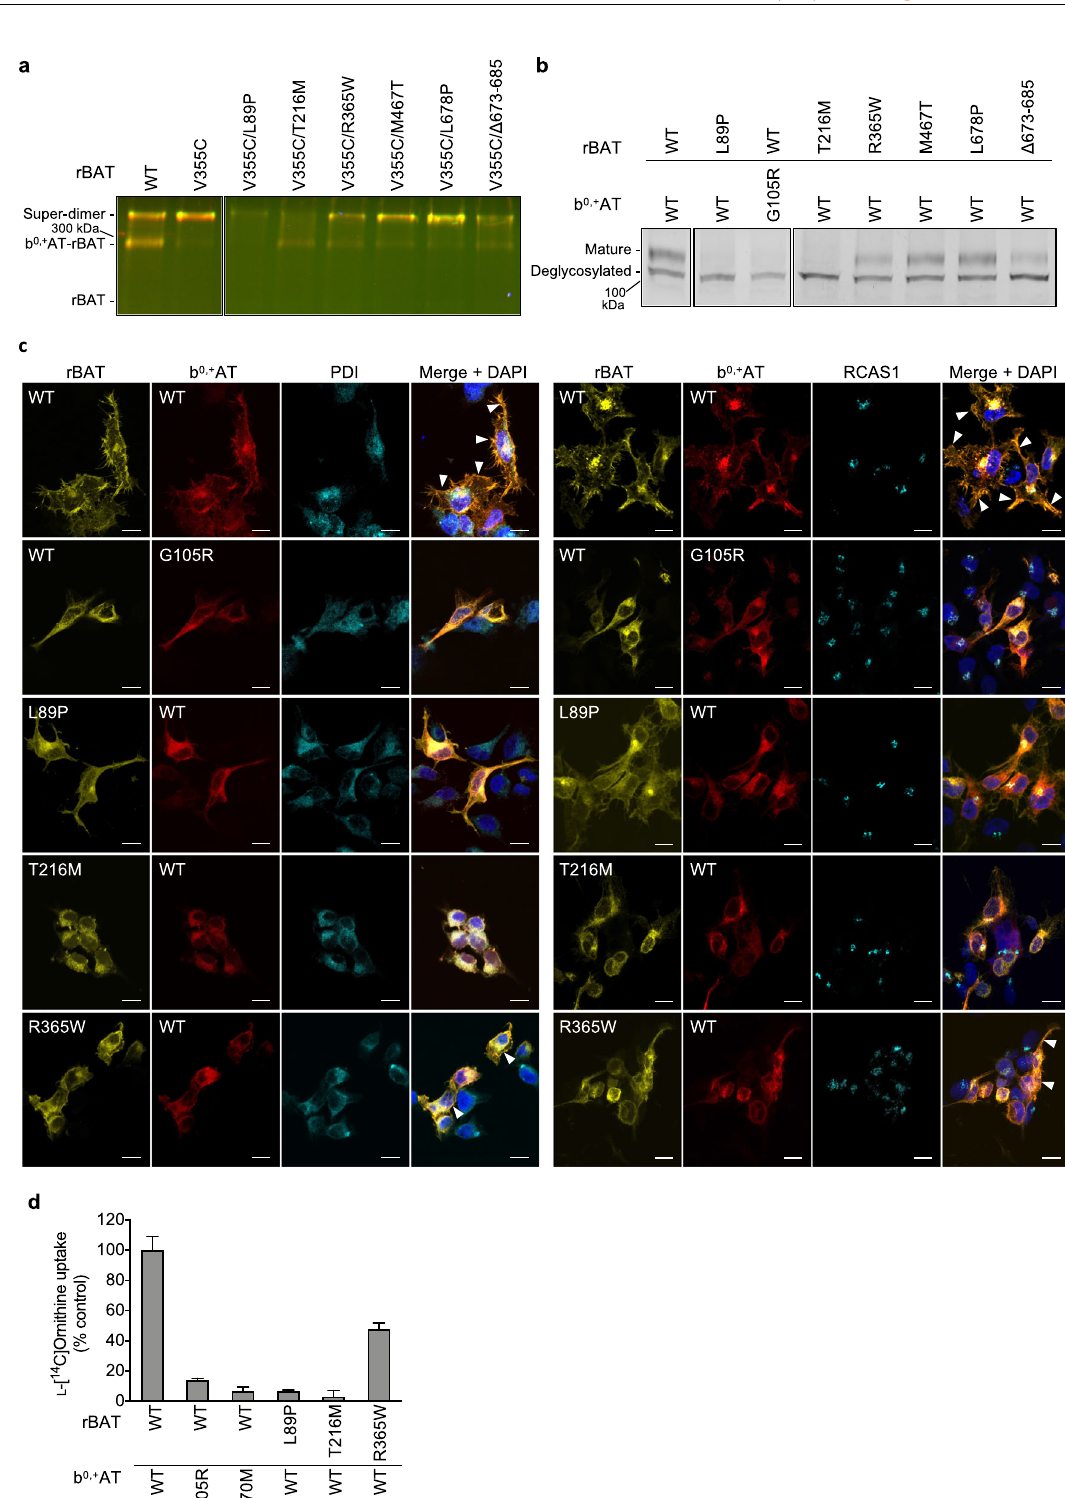
Fig. 8 Cystinuria mutants. a Cross-linking assay to evaluate the super-dimerization for cystinuria mutants. Overlay of GFP and mCherry fl uorescence channels on non-reducing SDS-PAGE are displayed. b Endo H assay to evaluate the N-glycan maturation for cystinuria mutants. c Fluorescence imaging of HeLa cells expressing GFP-rBAT (yellow) and mCherry-b 0, + AT (red) or the indicated mutants. Fluorescent staining with anti-PDI (cyan in the left panel) and anti-RCAS1 (cyan in the right panel) antibodies were used as markers for ER and Golgi apparatus, respectively. Plasma membrane localization of b 0, + AT-rBAT are indicated in the white arrowheads. Scale bar = 10 μ m. d Uptake of 100 μ M ʟ -[ 14 C]-ornithine in HEK293 cells transfected with wild-type b 0, + AT and rBAT or the indicated mutants. Net uptake was normalized to WT set as 100%. Values are mean ± SEM. n = 4 technical